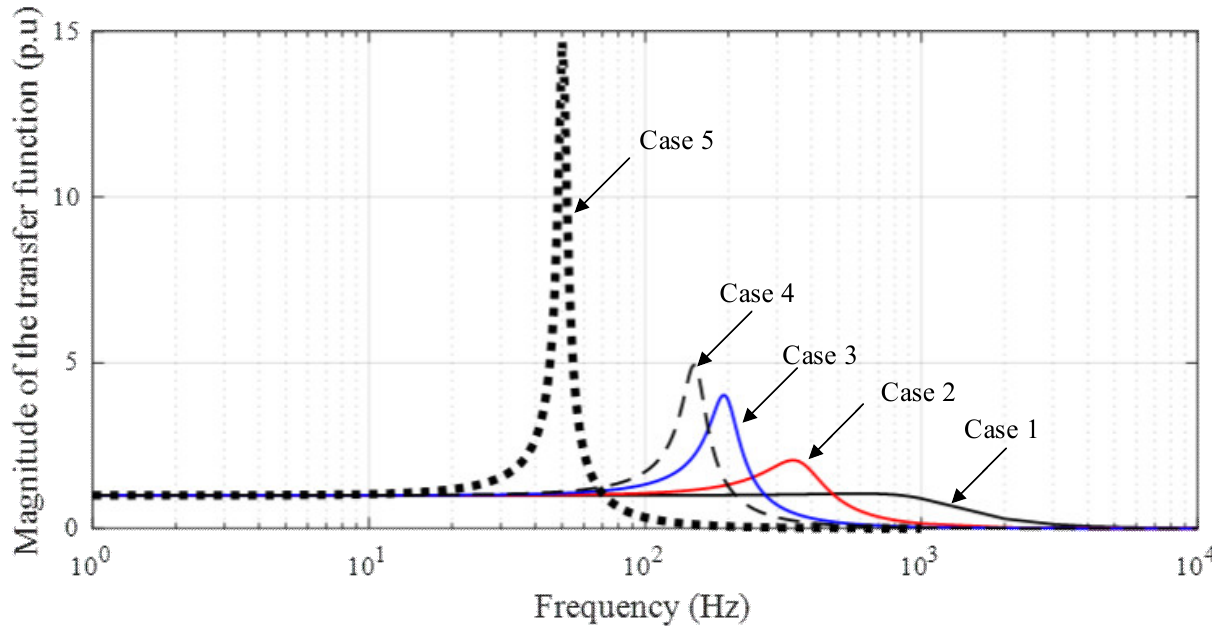
Figure 14. The transfer function magnitudes in the frequency domain in cases of different circuit parameters of the tuning and filter circuit.